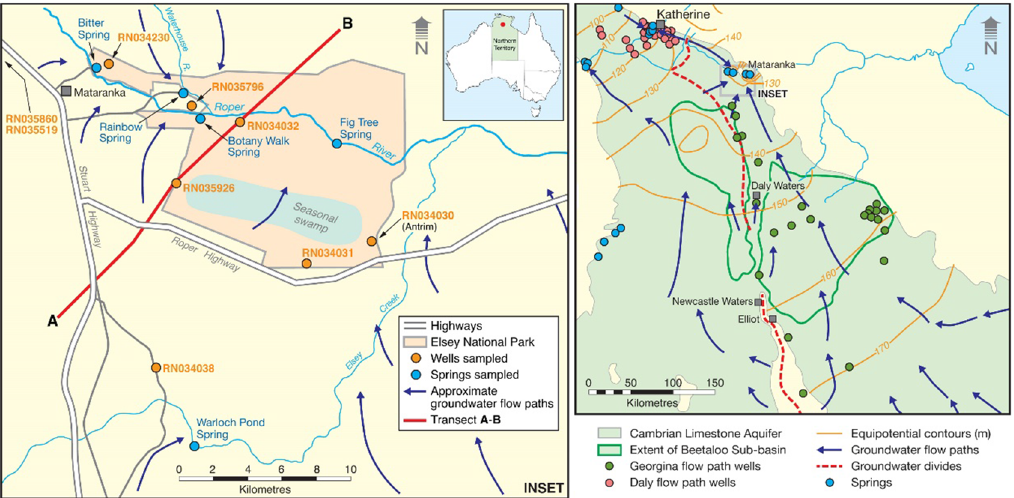
Figure 1. Mataranka Springs Complex, Northern Territory. The complex is a regional groundwater discharge zone for the Cambrian Limestone Aquifer, via a flow path from the north in the Daly Basin (Daly flow path), where the springs are also located, and another from the south in the Georgina Basin (Georgina flow path) 2 . Geological cross-section along A-B shown on Fig. 2. The Beetaloo Sub-basin of the Georgina Basin is to the south of the springs (see Fig. 2 for details). The springs and groundwater wells sampled in this study are all located in the vicinity of the Mataranka Springs Complex (inset). For major ions and stable isotopes of water, literature values from the Georgina and Daly basins were also used to characterise the signature for